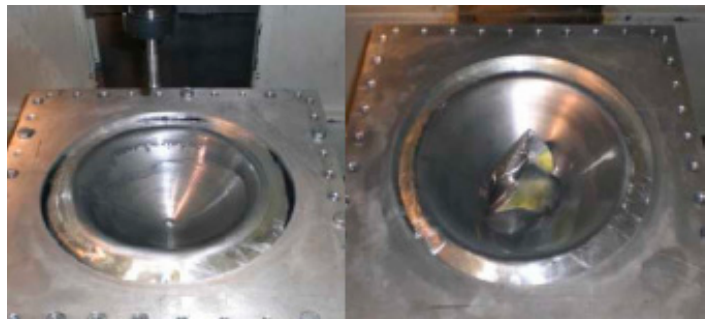
Figure 19. Mechanical failure on formed FML (reprinted with permission from [265]; copyright© 2021, Springer-Verlag France).